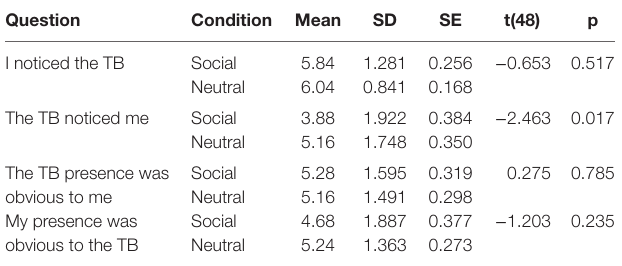
TaBle a6 | Social presence: social vs neutral results.